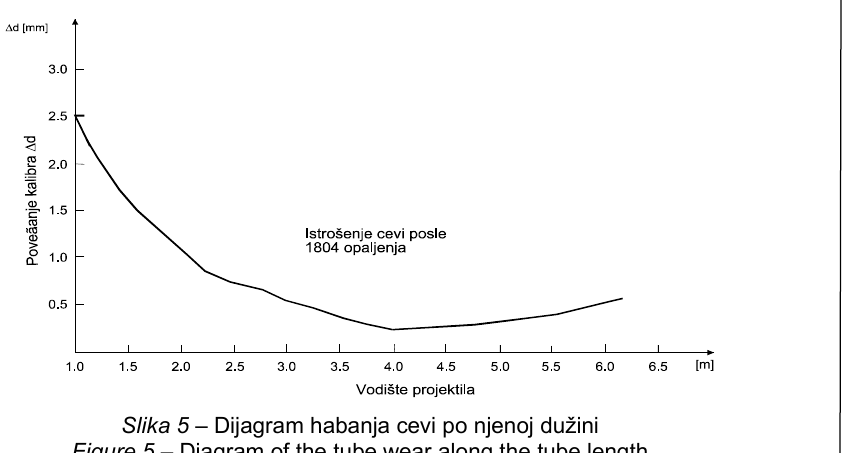
Figure 5 – Diagram of the tube wear along the tube length